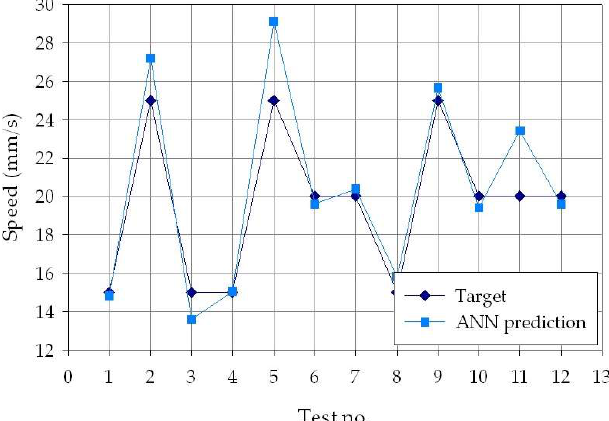
Figure 7. Experimental (blue diamond marks) and ANN-estimated (light blue square marks) welding speed values, s , for each of the p = 30 experimental conditions.